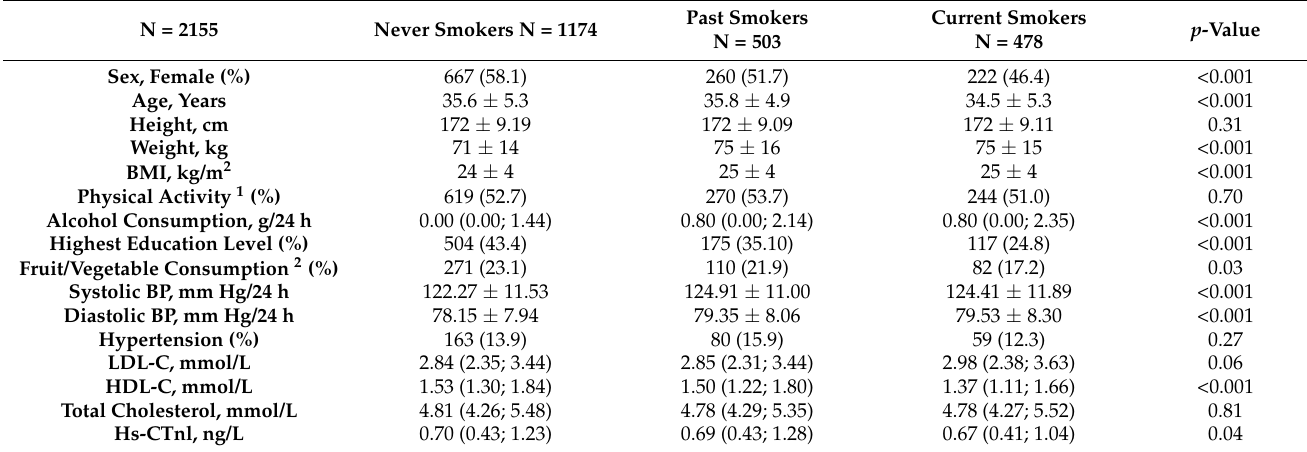
Table 1. Baseline characteristics according to smoking status.